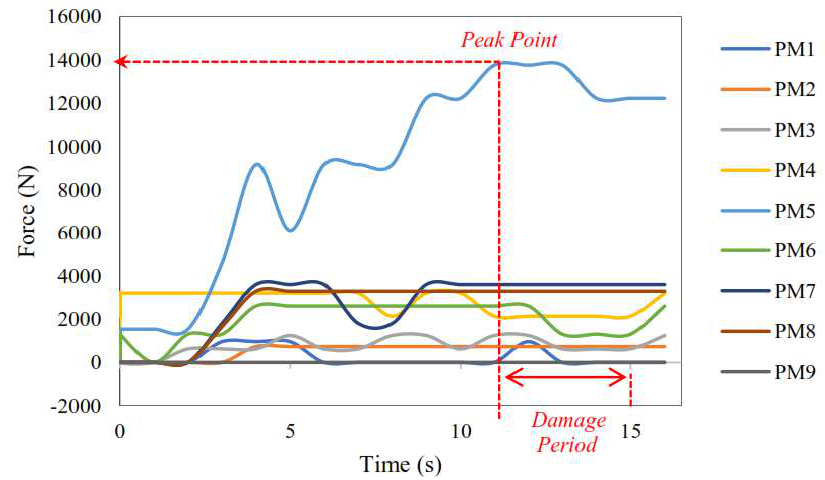
Figure 15. Graph of 1 m reservoir water level test of the frame.